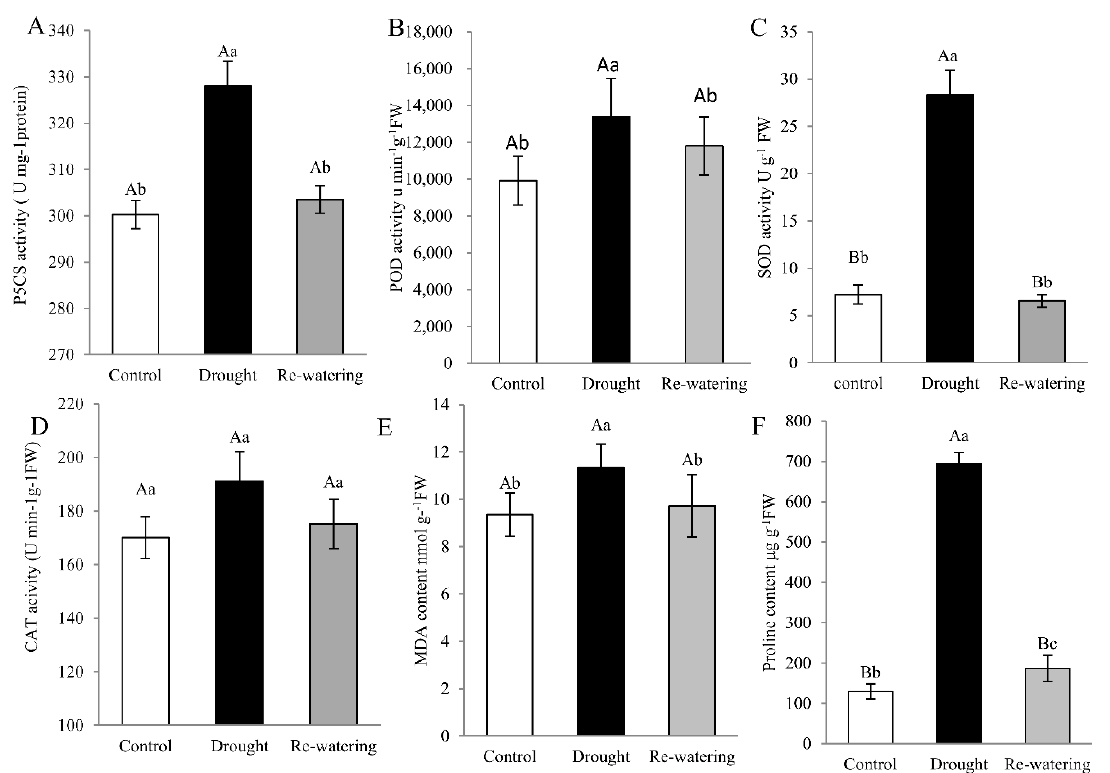
Figure 2. Physiologic parameters in Jigu 16 foxtail millet leaves under drought stress and re-watering conditions. Total activity of P5CS ( A ) and the antioxidant enzymes, peroxidase (POD) ( B ), superoxide dismutase (SOD) ( C ), and catalase (CAT) ( D ) in Jigu 16 after 9 days drought stress and 12 h re-watering conditions. Malondialdehyde (MDA) ( E ) and proline ( F ) content in foxtail millet after 9 days drought stress and 12 h re-watering conditions. Each column represents the mean ± SD ( n = 3 pools of x plants). Significance levels were determined by one-way ANOVA; Different letters above bars indicate significant differences, lowercase letter p < 0.05, uppercase letter p < 0.01.